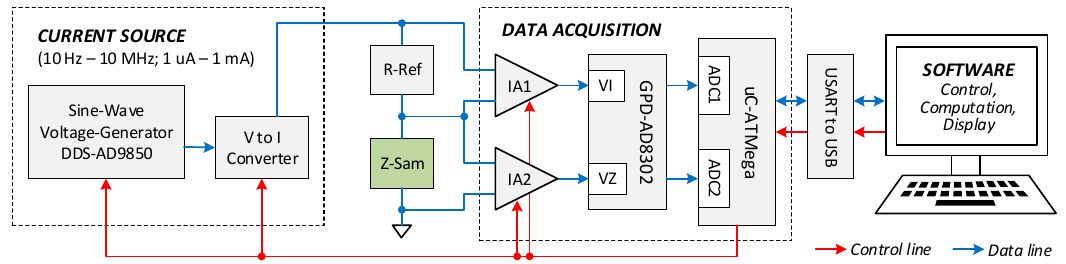
Figure 1. Block diagram of the developed BIS instrumentation system .